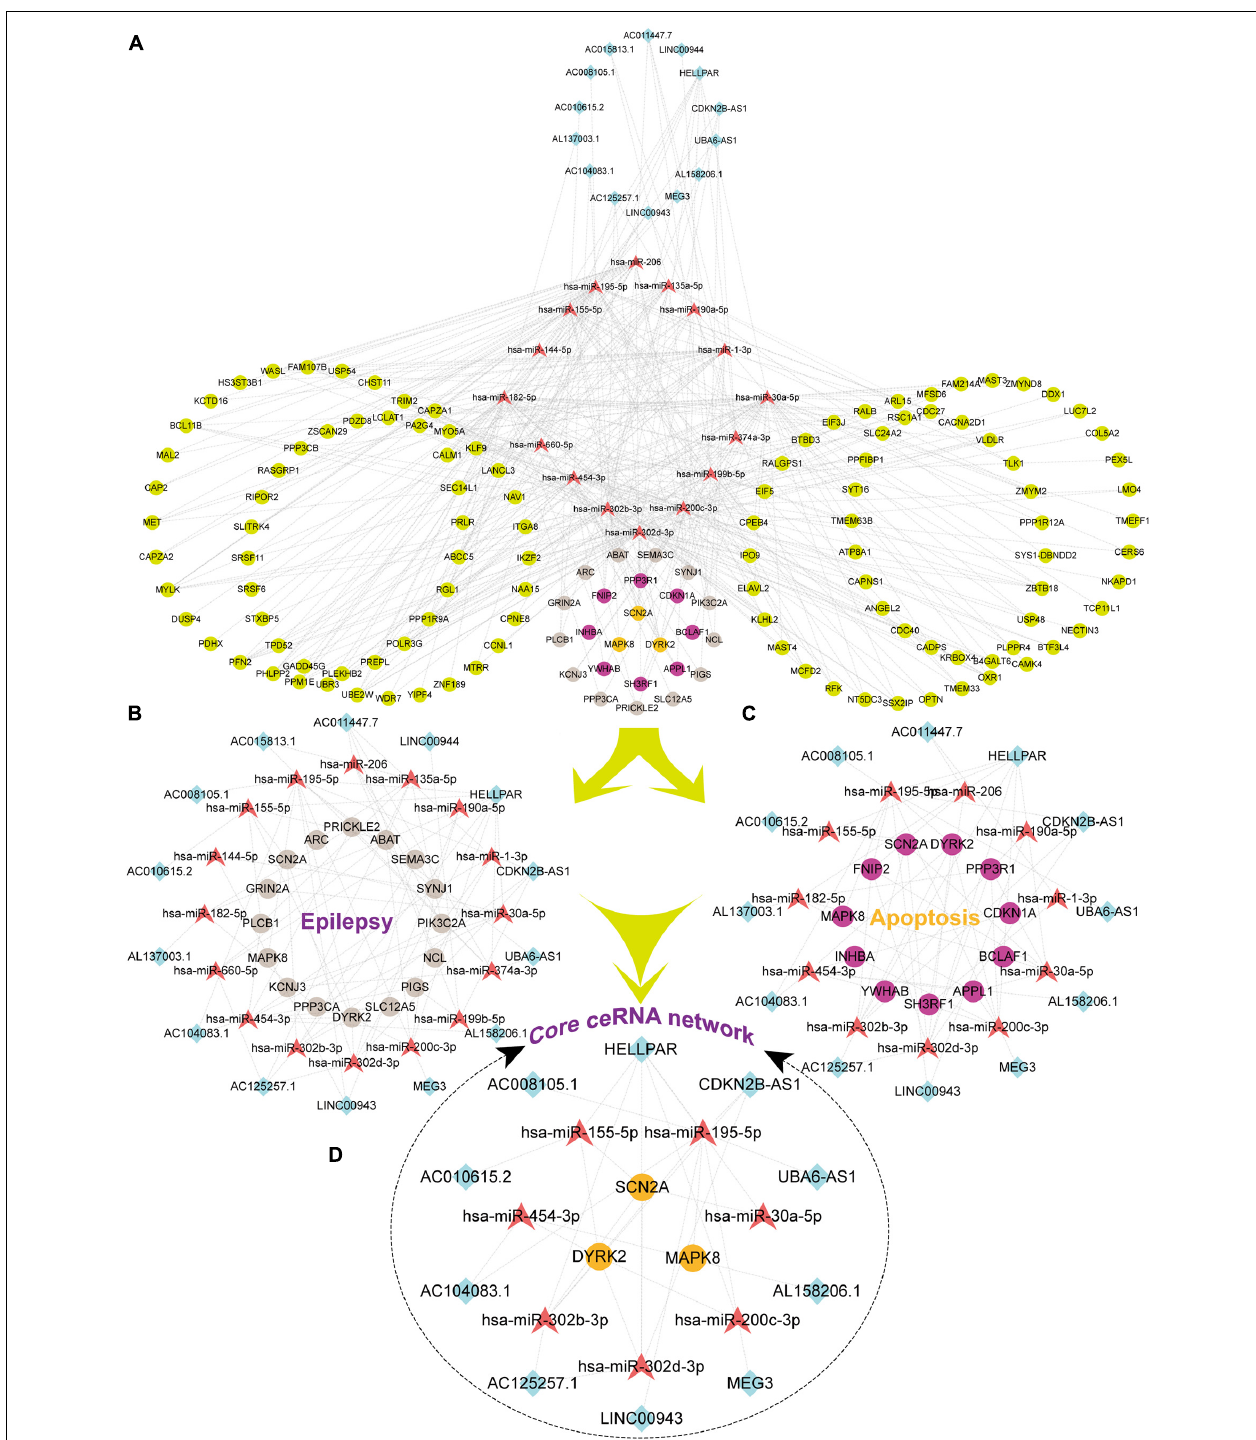
FIGURE 5 | The Down lncRNA-miRNA-mRNA ceRNA network and three sub-networks. Squares represent DElncRNAs, whereas triangles represent DEmiRNAs, and circles represent DEmRNAs. Fuchsia represents up-regulated and other colors represent down-regulated. Light earth color represents genes enriched by Epilepsy in DisGeNet, whereas rose-red represents genes enriched in the apoptotic pathway, and orange color indicates that the genes were enriched both in epilepsy and pathways of apoptotic. (A) The Down ceRNA network; (B) the ceRNA network of Epilepsy; (C) the ceRNA network of Apoptosis; (D) the core ceRNA network of Epilepsy and